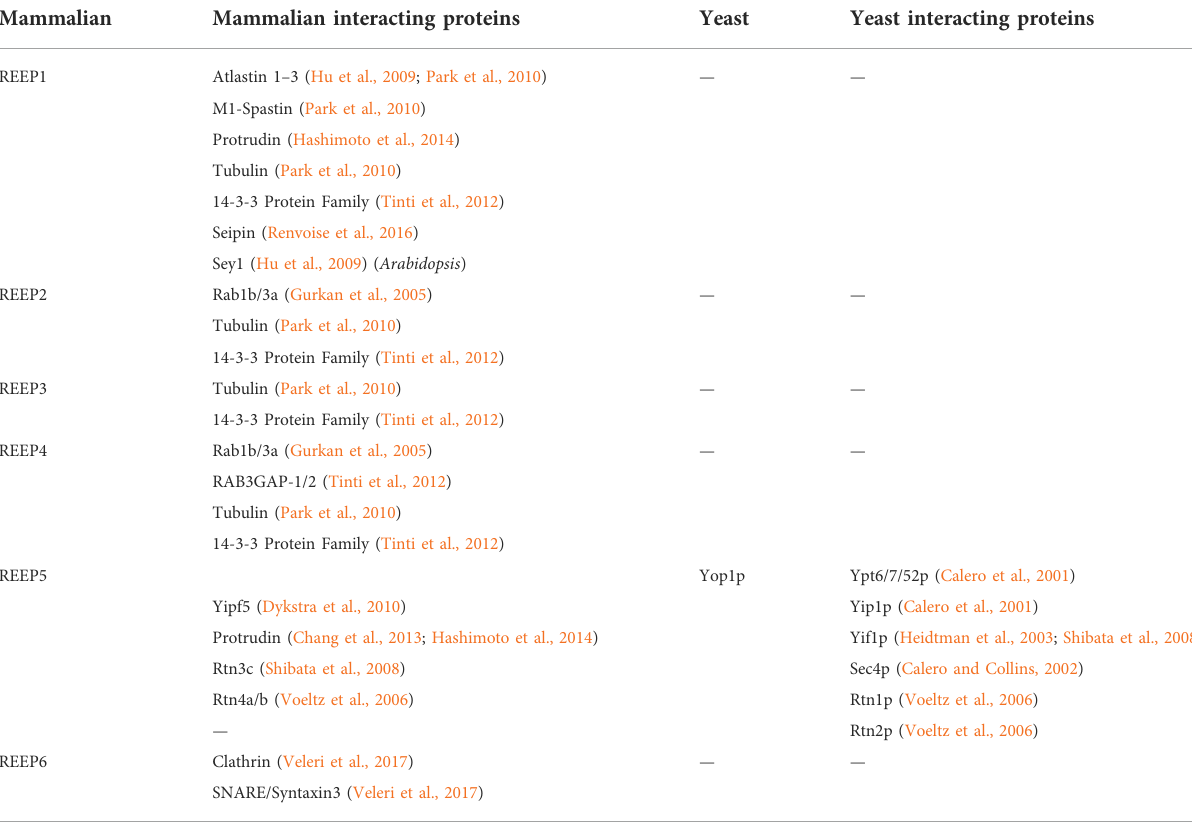
TABLE 4 REEP/Yip2 family interacting